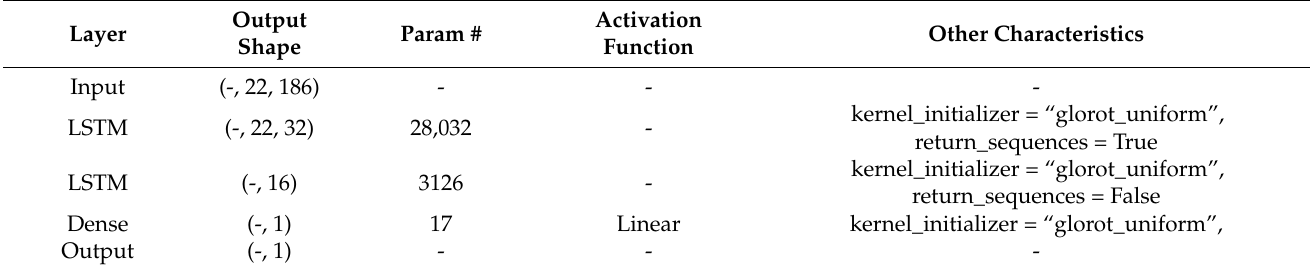
Figure 8. RNN architecture and structure inside an LSTM neuron. Table 2. Configuration details and number of parameters for all layers of the deep learning architecture using features from 2-s wub-windows as input.